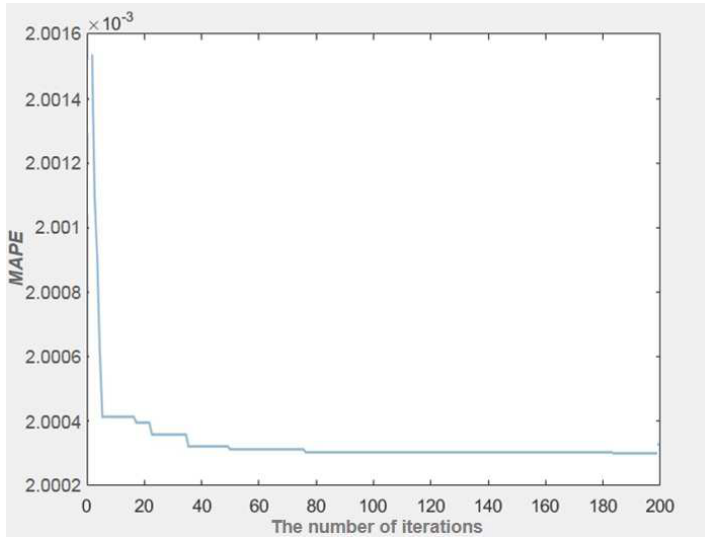
Figure 3. The convergence process of MAPE. Table 3. The MAPE of the GM (1,1) model and the FGM (1,1) model (%).